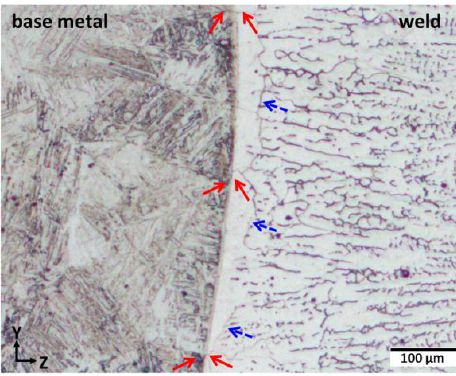
Figure 6 . Optical micrograph of the weld after a two-step etching: Nital and Electro-nitric. Solid arrows (in red) highlight the continuity of Type I grain boundaries across the fusion line. Type II grain boundaries almost parallel to the fusion line are also indicated by dotted arrows (in blue).